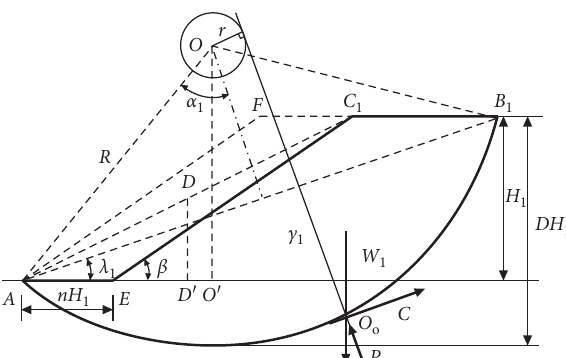
Figure 1: A simple slope model (adapted from Taylor